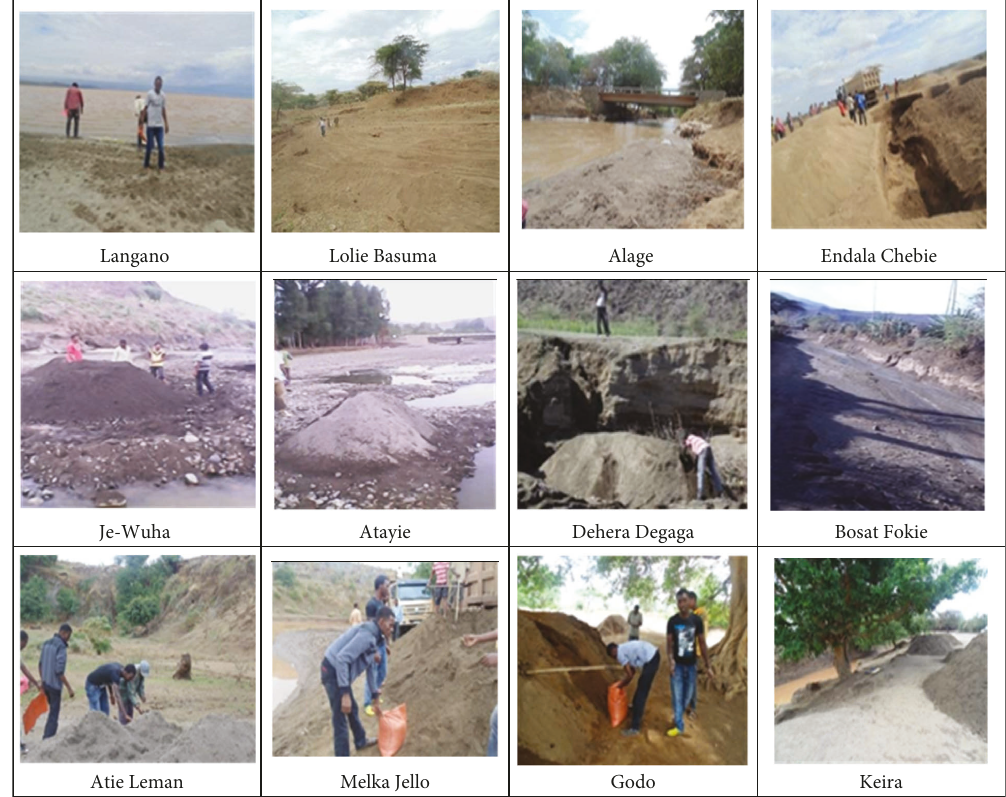
Figure 1: Quarry sites captured overview (source: captured during sample collection from